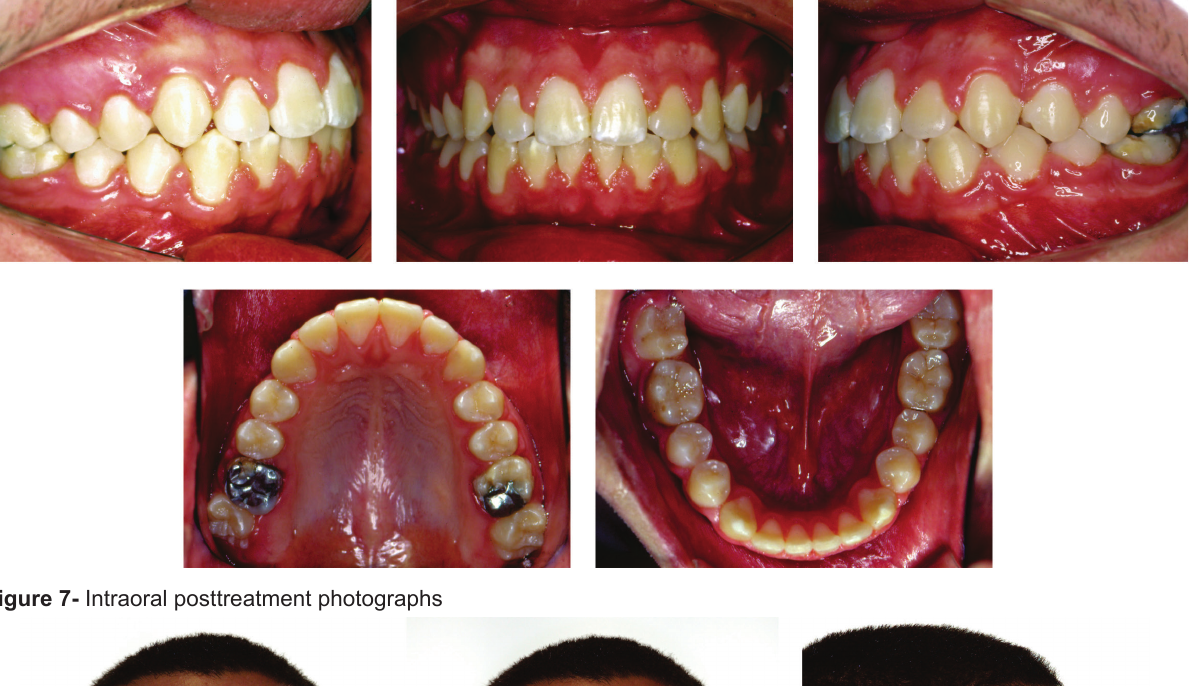
Figure 7- Intraoral posttreatment photographs